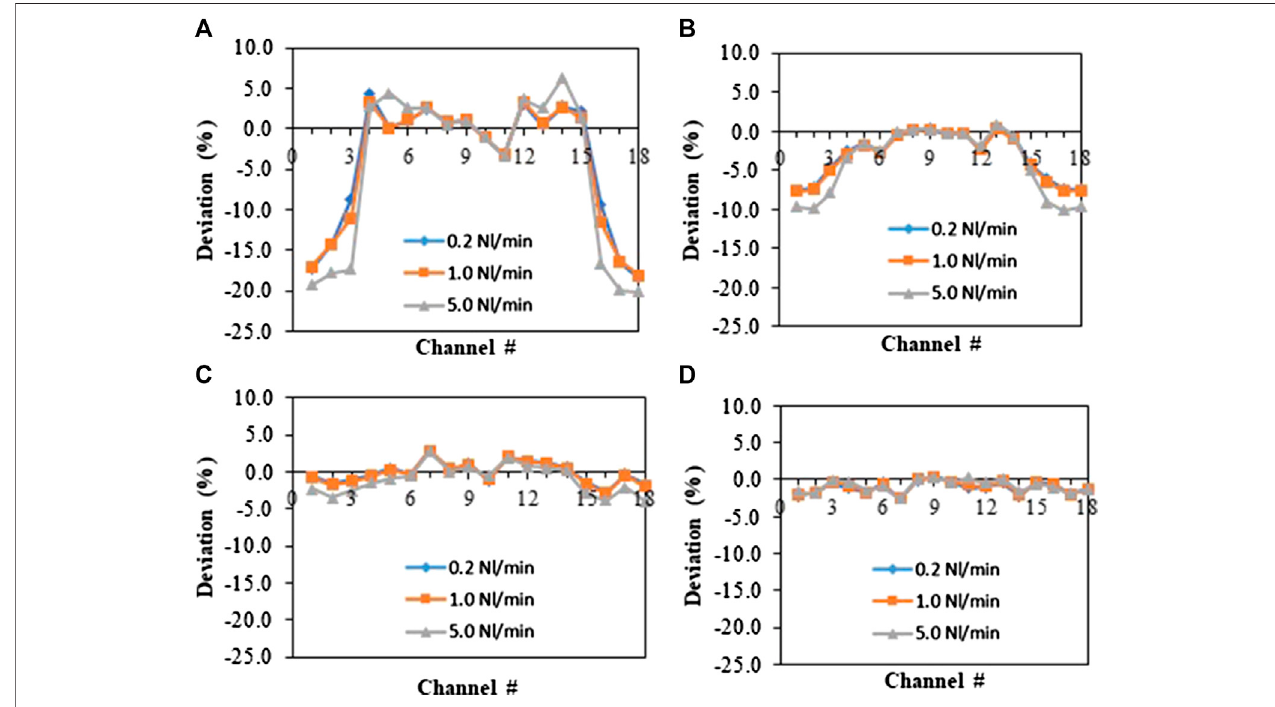
FIGURE 3 | Deviation of the maximal longitudinal velocity in each channel relative to the middle channels (Channels 9 and 10) at different axial positions inside the monolithic structure in the reference situation. (A) 0.1 cm, (B) 0.5 cm, (C) 1 cm, and (D) 2 cm; Flow rates of 0.2 Nl/min (blue), 1 Nl/min (orange), 5 Nl/min (gray).